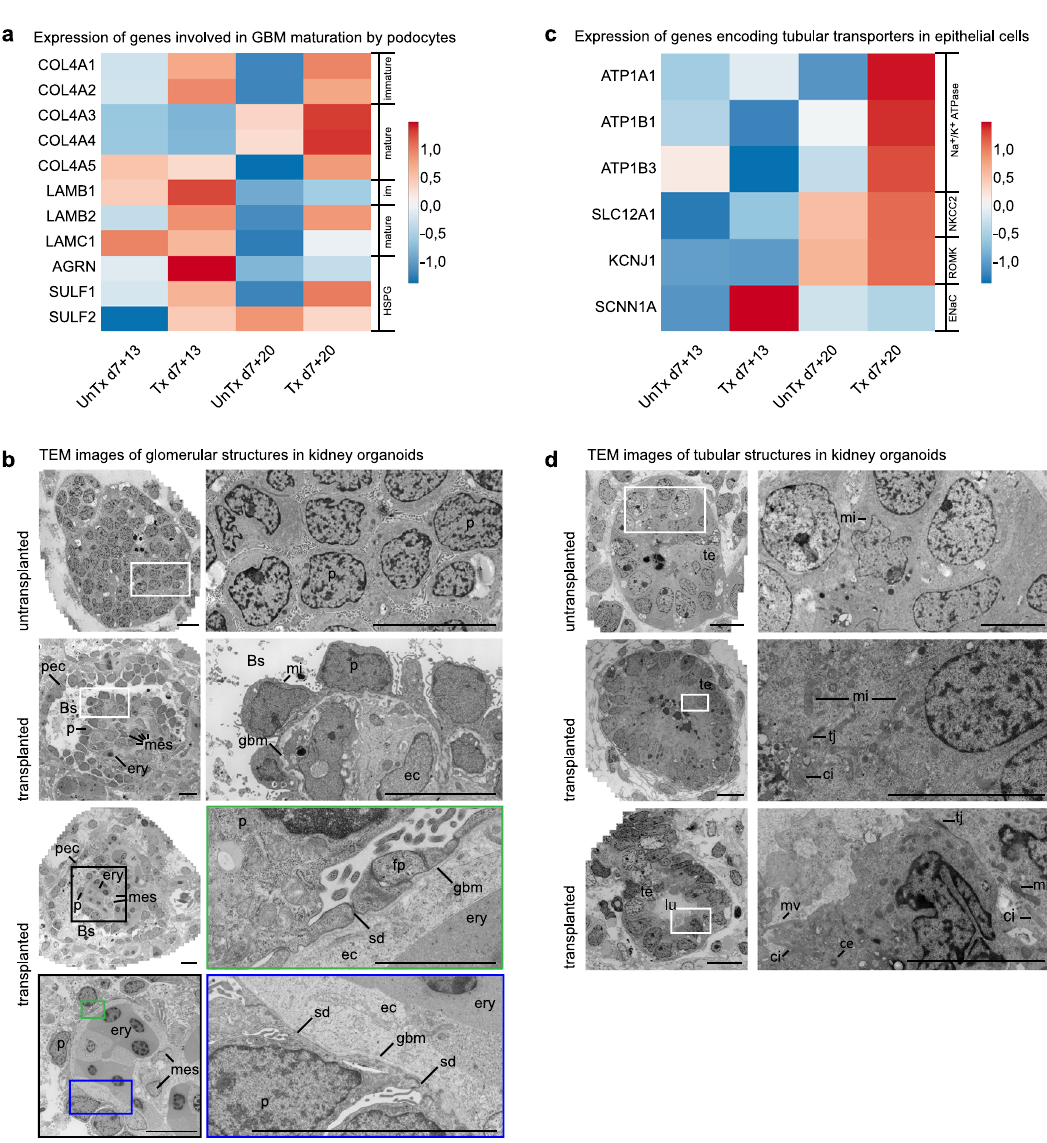
Fig. 4 hiPSC-derived kidney organoids mature upon transplantation. a Expression-level scaled heatmap of genes involved in GBM development in podocytes in untransplanted versus transplanted kidney organoids at different timepoints. COL4A3-5 and LAMB2 are upregulated in d7 + 20 transplanted podocytes compared to all other conditions, fi tting with the switch from collagen IV α 1 α 2 α 1 to collagen IV α 3 α 4 α 5 and from laminin β 1 to laminin β 2 during GBM maturation. LAMC1 and AGRN , encoding laminin γ 1 and agrin (a heparan sulfate proteoglycan HSPG) in the mature GBM are not upregulated in d7 + 20 transplanted podocytes, implying the GBM in the organoids is not fully matured. Scale: z-score of the gene expression level. b Transmission Electron Microscopy (TEM) imaging displays maturation of glomerular structures upon transplantation for 8 days. Podocyte clusters are invaded with capillaries containing erythrocytes and supported by mesangial cells. Parietal epithelial cells form a Bowman ’ s capsule, a glomerular basement membrane is deposited between the podocytes and endothelial cells, and rudimentary slit diaphragms are formed between primitive foot processes. Magni fi cations of the boxed areas are displayed, Bs Bowman ’ s space , ec endothelial cell , ery erythrocyte, fp foot process , gbm glomerular basement membrane, leu leukocyte, mes mesangial cell, mi mitochondrion, p podocyte , pec parietal epithelial cell , sd slit diaphragm. Scale bars 10 µm. Scale bar magni fi cation marked in green 2 µm. c Expression-level scaled heatmap of genes encoding tubular transporters in untransplanted versus transplanted kidney organoids at different timepoints. Expression of genes encoding the transporters Na + /K + ATPase, NKCC2 and ROMK are upregulated in transplanted organoids at d7 + 20. SCNN1A , which encodes the α -subunit of the ENaC channel, is not upregulated. Scale: z-score of the gene expression level. d Upon transplantation for 8 days, tubular structures also show signs of maturation. Tubular epithelial cells have formed a monolayer and their nuclei have moved toward the basolateral side of the cell. Tight junctions, cilia, a centriole, microvilli and abundant mitochondria are visible. ce centriole, ci cilium, lu lumen, mi mitochondrion, mv microvilli, te tubular epithelium, tj tight junction. Scale bars images left row 10 µm, scale bars magni fi cations right row 5 µm. TEM Images based on 5 transplanted organoids from 2 experiments using 2 cell lines (MAFB (here)) and LUMC0072 (Supplementary Fig. 1C,